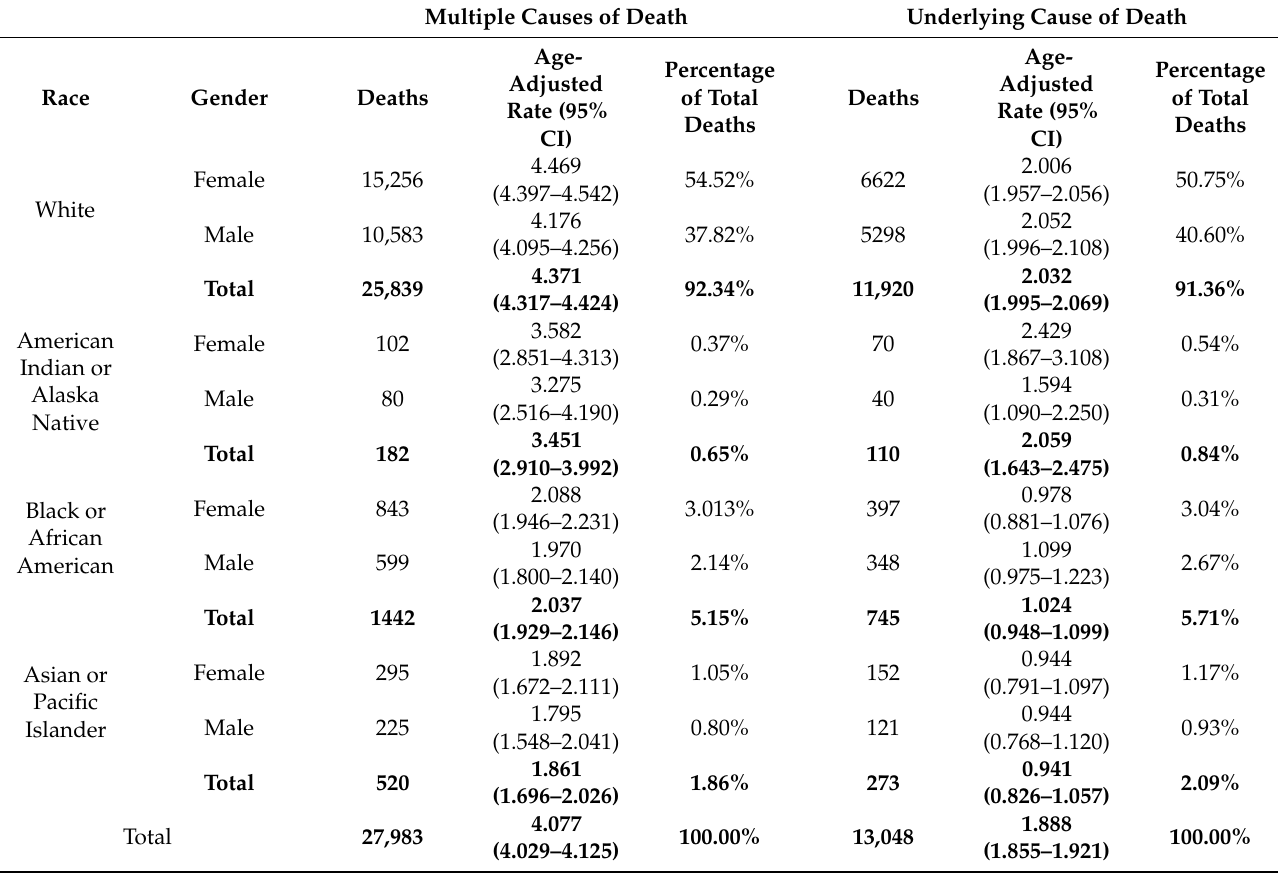
Figure 1. Decreases in the age-adjusted mortality rates for vasculitis as multiple ( left ) and underlying causes of death ( right ) by year, based on joinpoint analysis. APC, annual percent change. Table 1. Age-adjusted mortality rates per million for vasculitis as multiple causes of death and as underlying cause of death, by race and